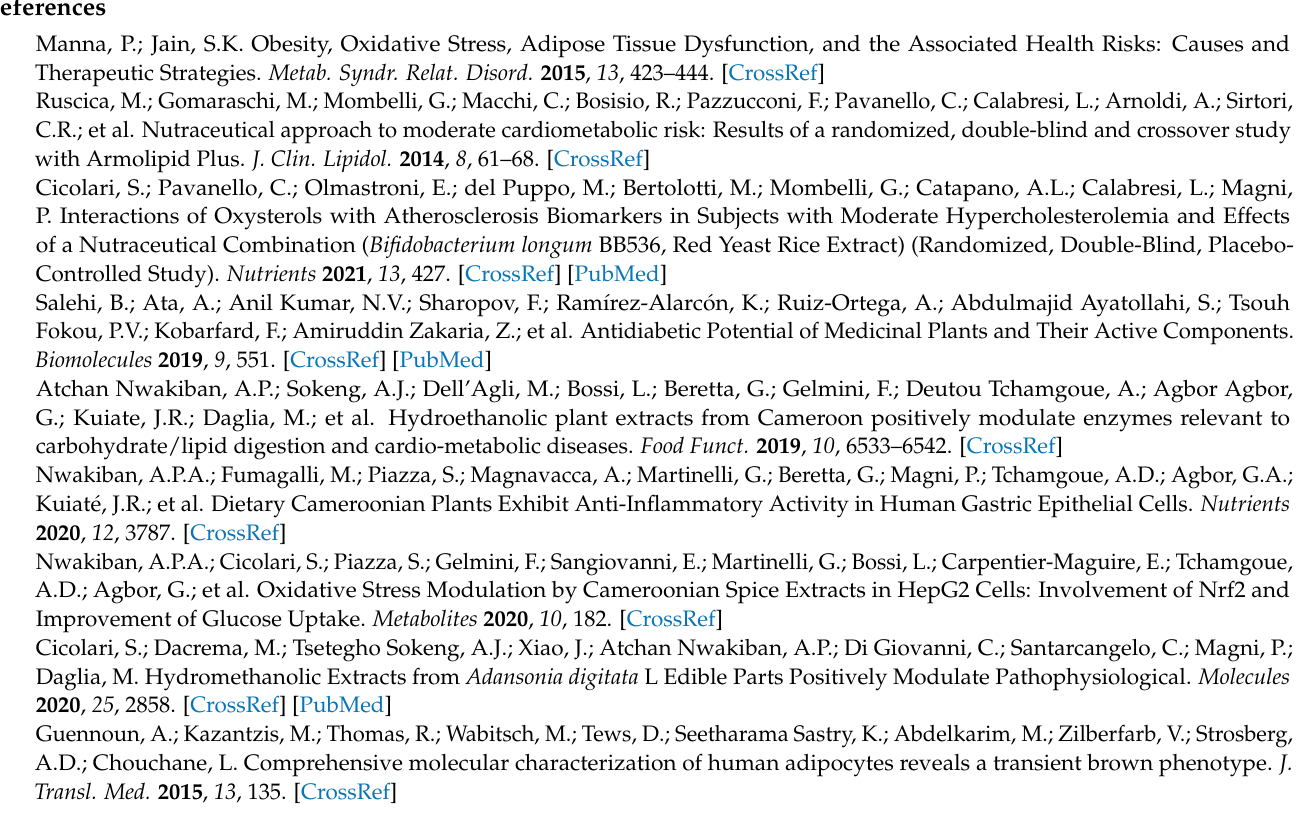
Figure S2: Intracellular complexity of non-differentiated and differentiated SW 872 cells; Figure S3: Glucose uptake in SW 872 cells. Time course (15–60 min) and dose, response to insulin (10 nM–1 µ M) of glucose uptake in non-differentiated (A) and differentiated (B)